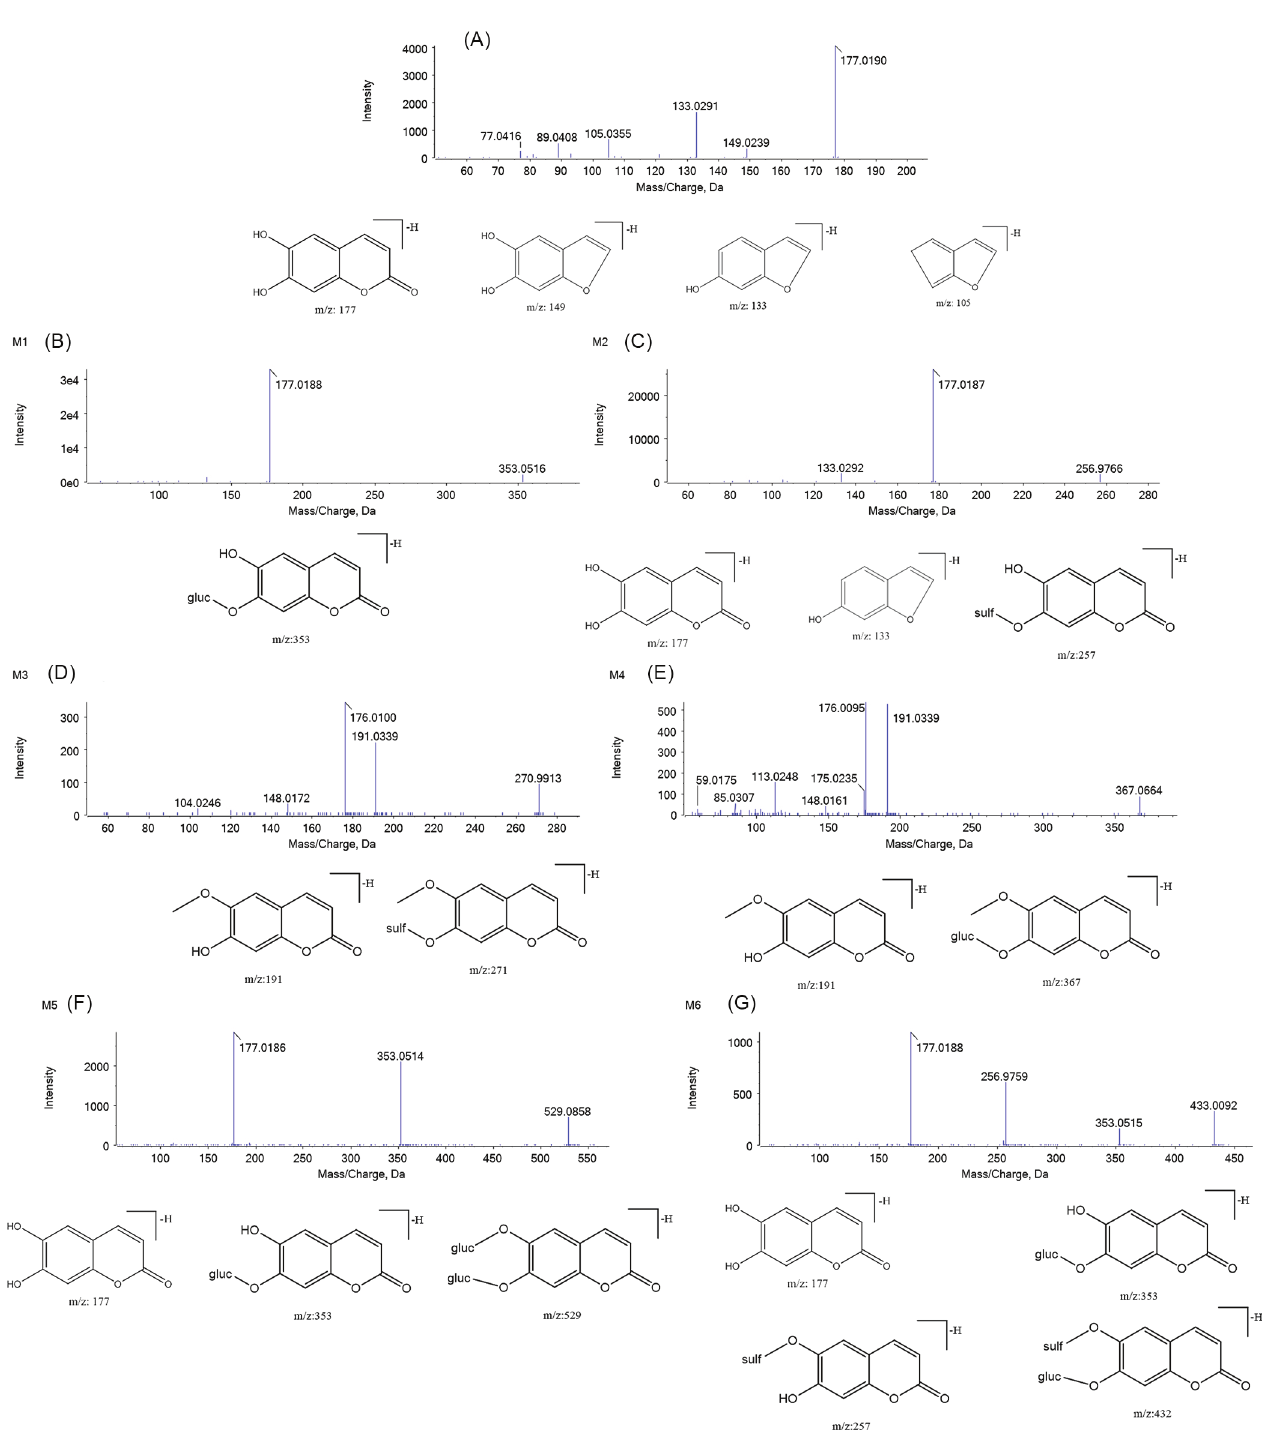
FIGURE 5 - Mass spectra (MS/MS) of esculetin and its possible metabolites. (A) Esculetin, (B) M1, (C) M2, (D) M3, (E) M4, (F) M5, and (G)